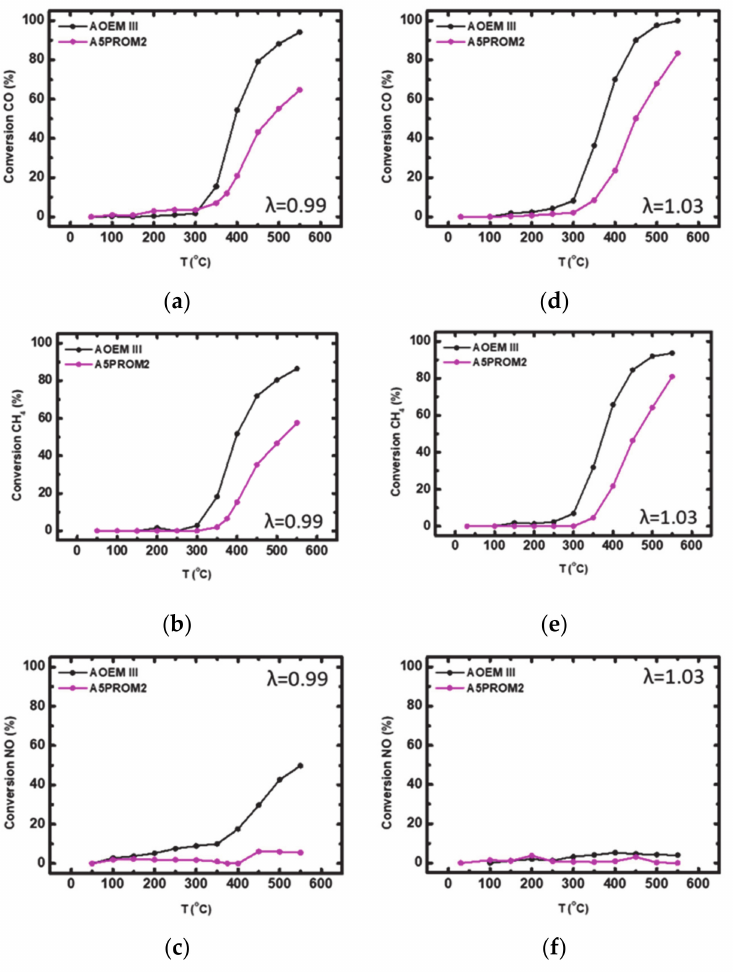
Figure 12. Light-off curves for the (%) conversion of: ( a ) CO; ( b ) CH 4 ; ( c ) NO under rich-burn conditions ( λ = 0.99); ( d ) CO; ( e ) CH 4 ; ( f ) NO under lean-burn-conditions ( λ = 1.03) over aged